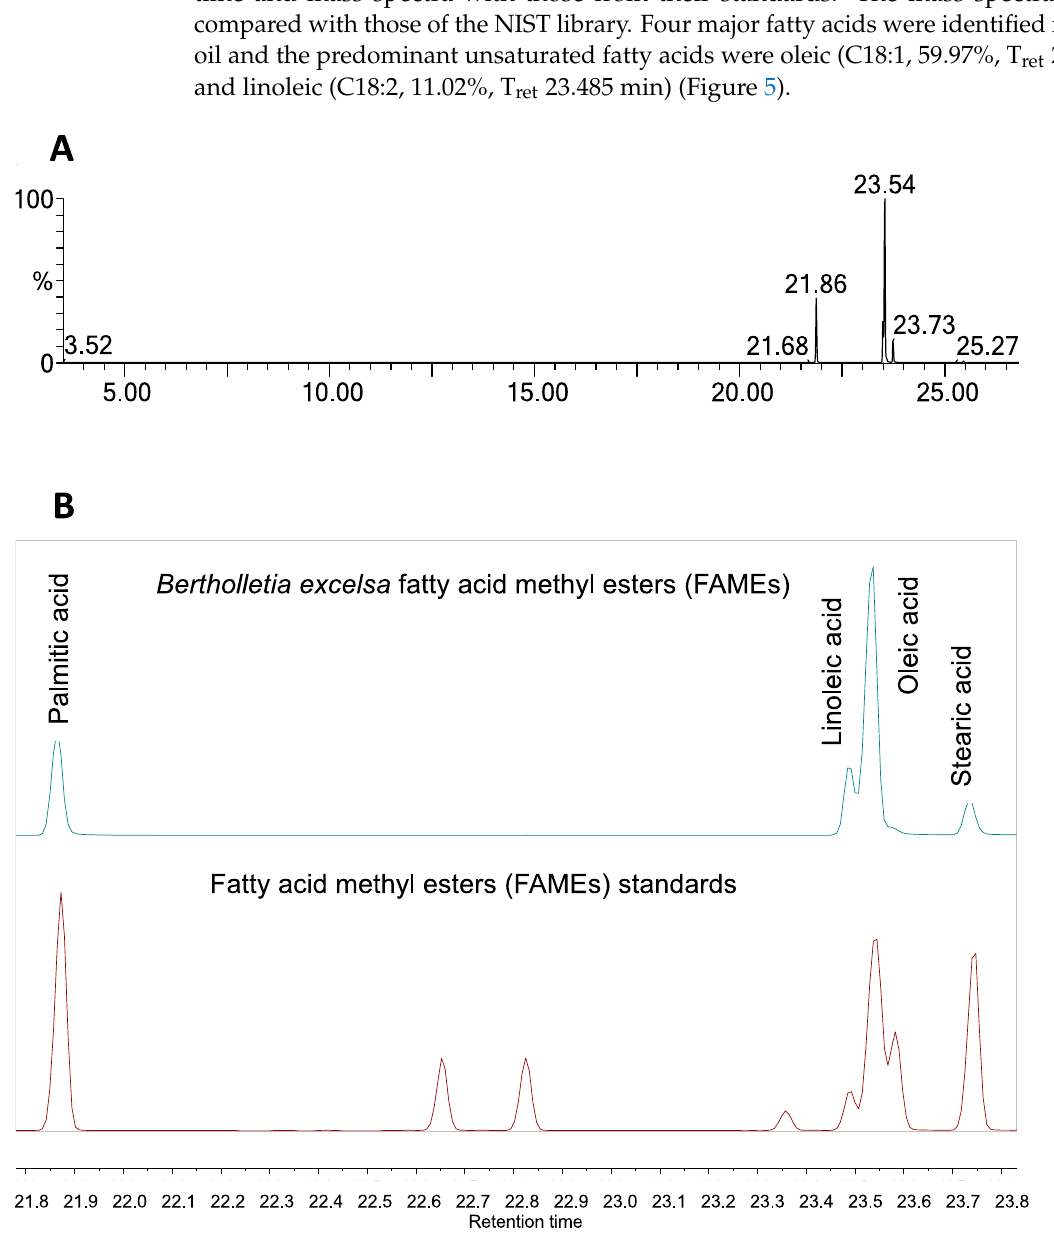
Figure 5. GC-MS chromatogram of B. excelsa oil ( A ) and major fatty acid methyl esters identified and compared to the standards ( B ).